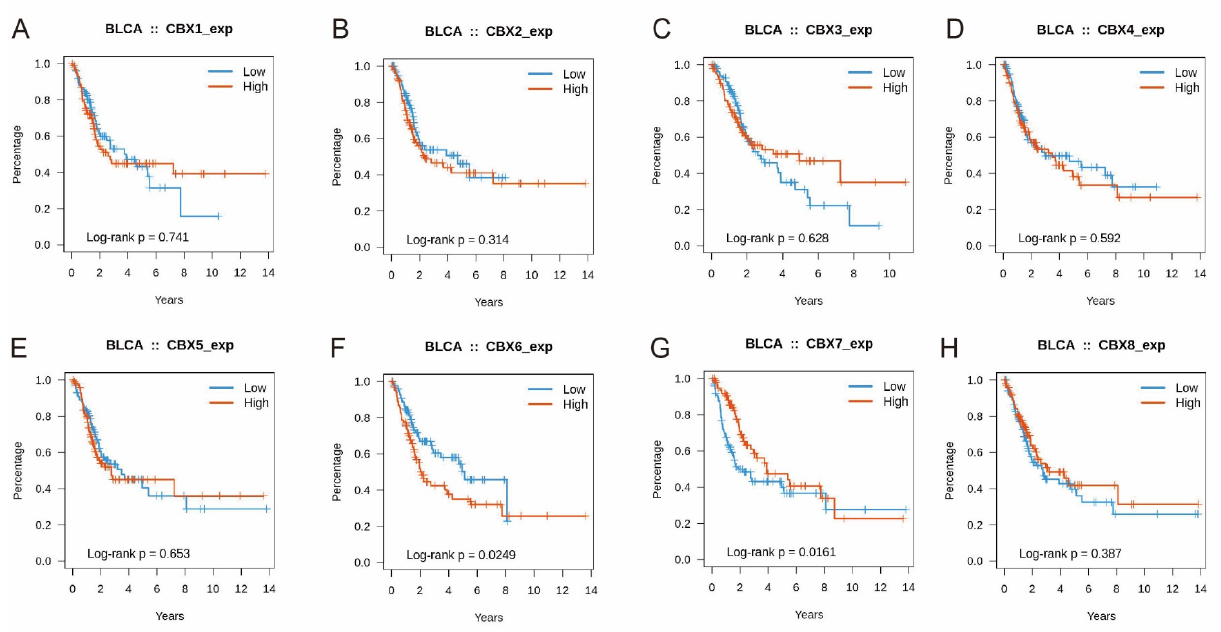
Figure 4. The overall survival rates of CBXs in BLCA were analyzed in TISIDB ( A ) CBX1; ( B ) CBX2; ( C ) CBX3; ( D ) CBX4; ( E ) CBX5; ( F ) CBX6; ( G ) CBX7; ( H ) CBX8. The p -values were calculated utilizing the log-rank test.